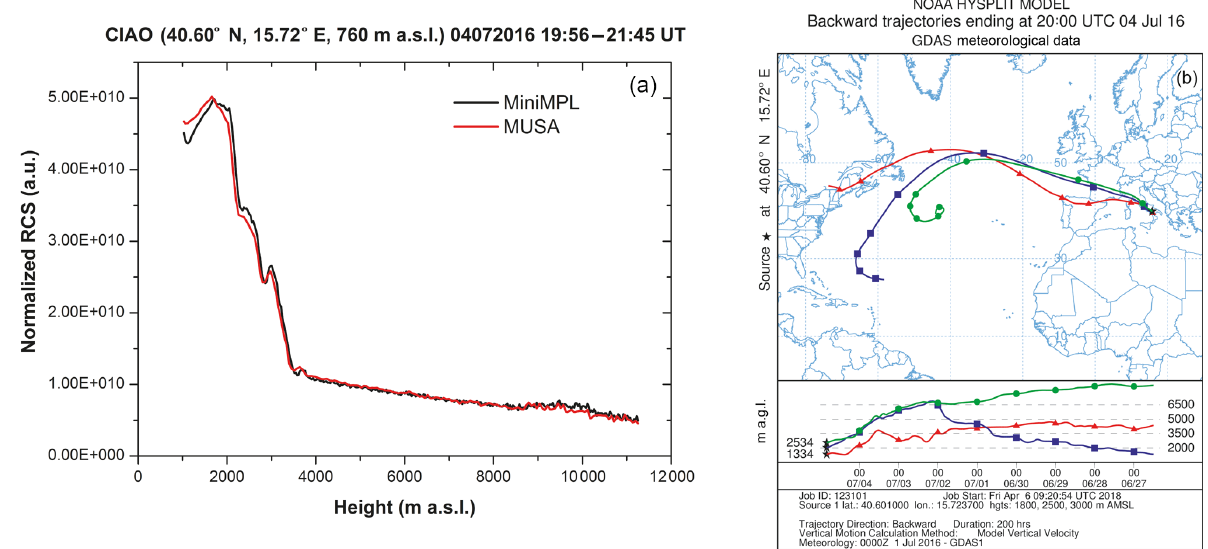
Figure 4. (a) Same as Fig. 3a but obtained from MUSA and MiniMPL on 4 July 2016 from 19:56 to 21:45UT. (b) Same as Fig. 3b; the corresponding air mass back-trajectory analysis performed using NOAA HYSPLIT model is